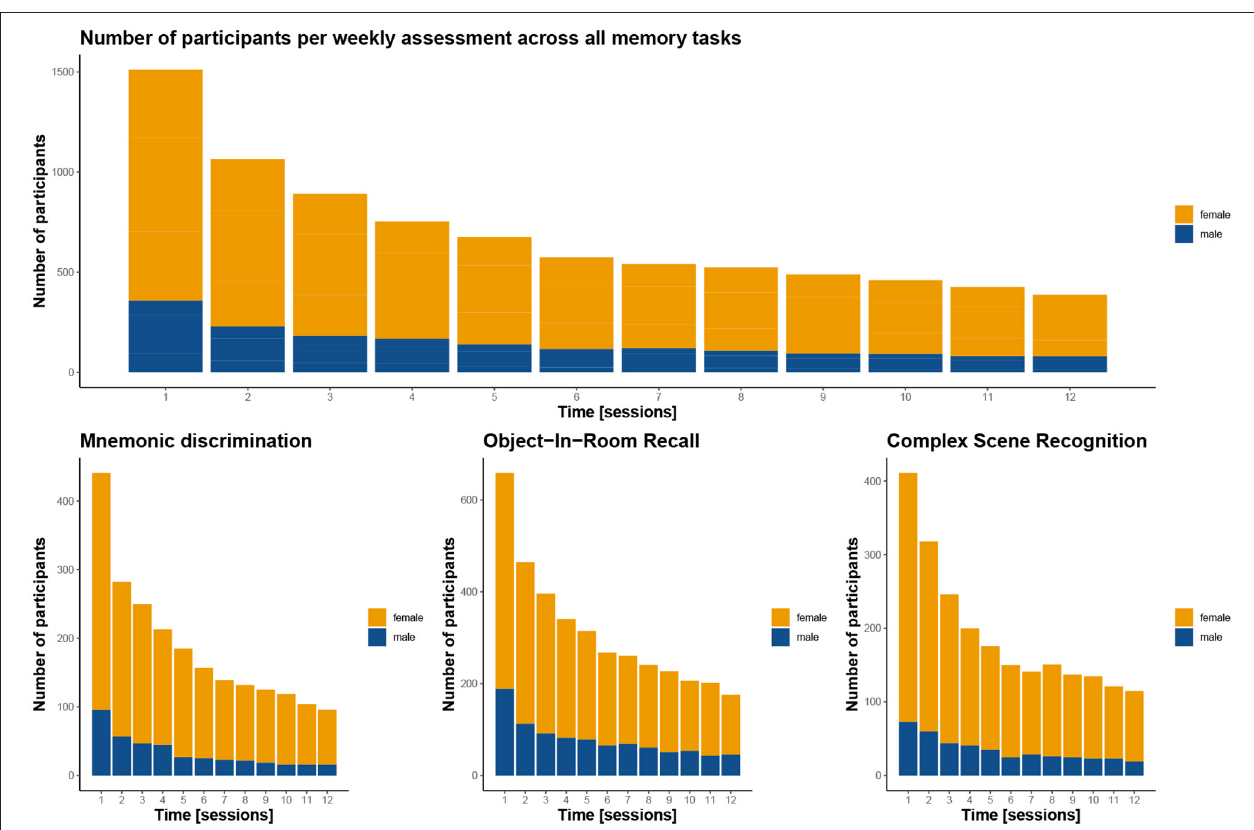
FIGURE 5 | Participant completion rates by test session. The graphs demonstrate for how many sessions the participants contributed to the study overall (top panel) and for the three memory tasks (bottom panel). Notably, in all three tasks, there is a gross initial loss after the first session, but dropout is greatly reduced in the weeks after. Women are depicted in orange, men in blue. Note, that the top panel includes 138 participants twice as they contributed to two of the tasks, resulting in a total of 1,545 instead of the 1,407 participants enrolled in the